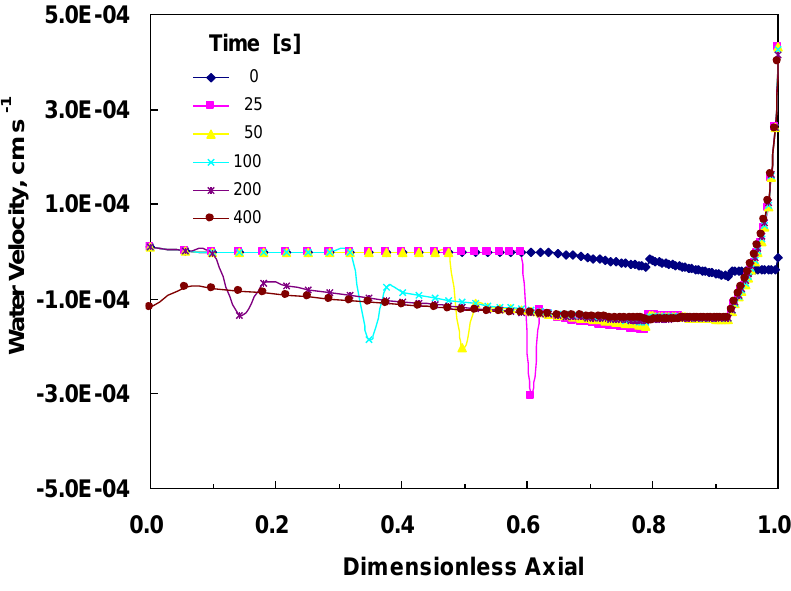
Figure 9. Distribution profile of water velocity during a step change of potential from 0.9 V to 0.4 V.